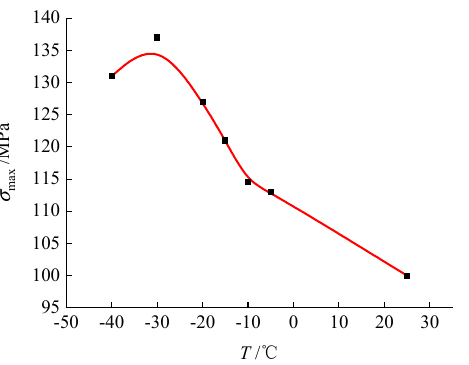
Figure 9. Dynamic compressive strength of dry red sandstone at different temperatures.